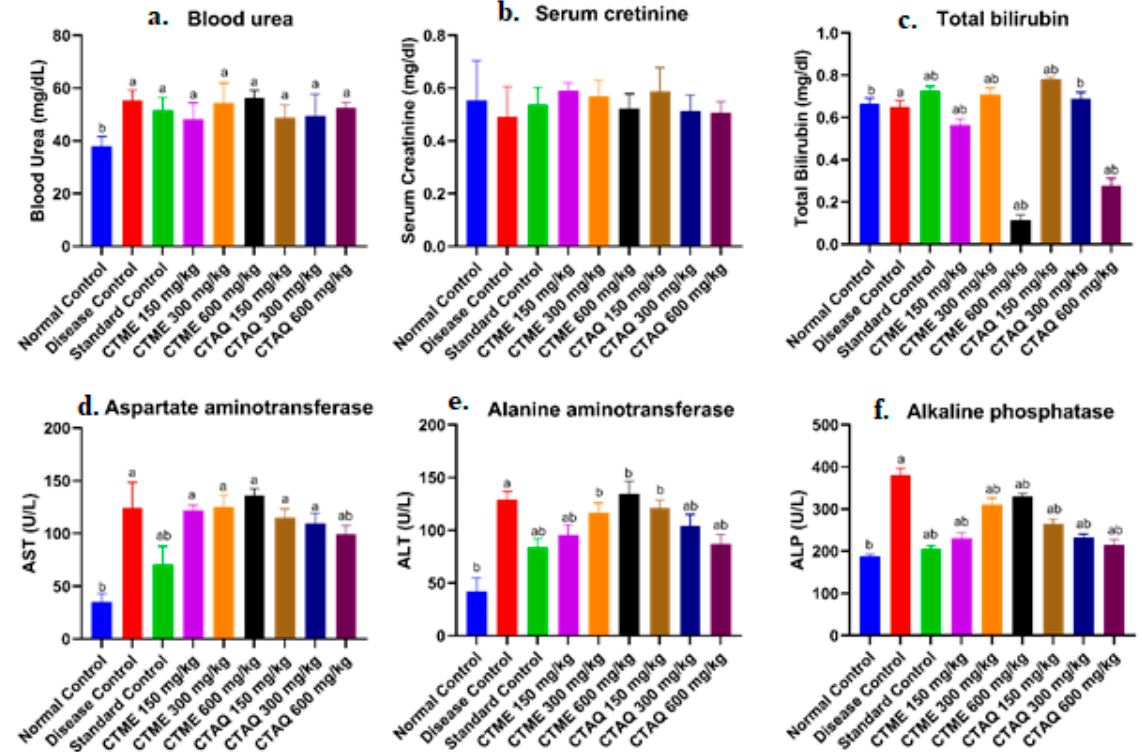
Figure 6. Effect of C. tuberculata extracts on kidney and liver function parameters. Values as mean ± S.D; ( n = 6), Results were significant as equated to a and b. Where a: NCG; b: DCG.